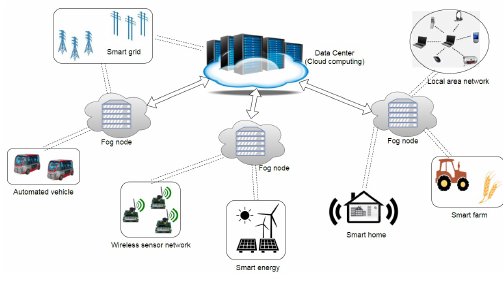
Figure 2. Applications in IoTs with fog